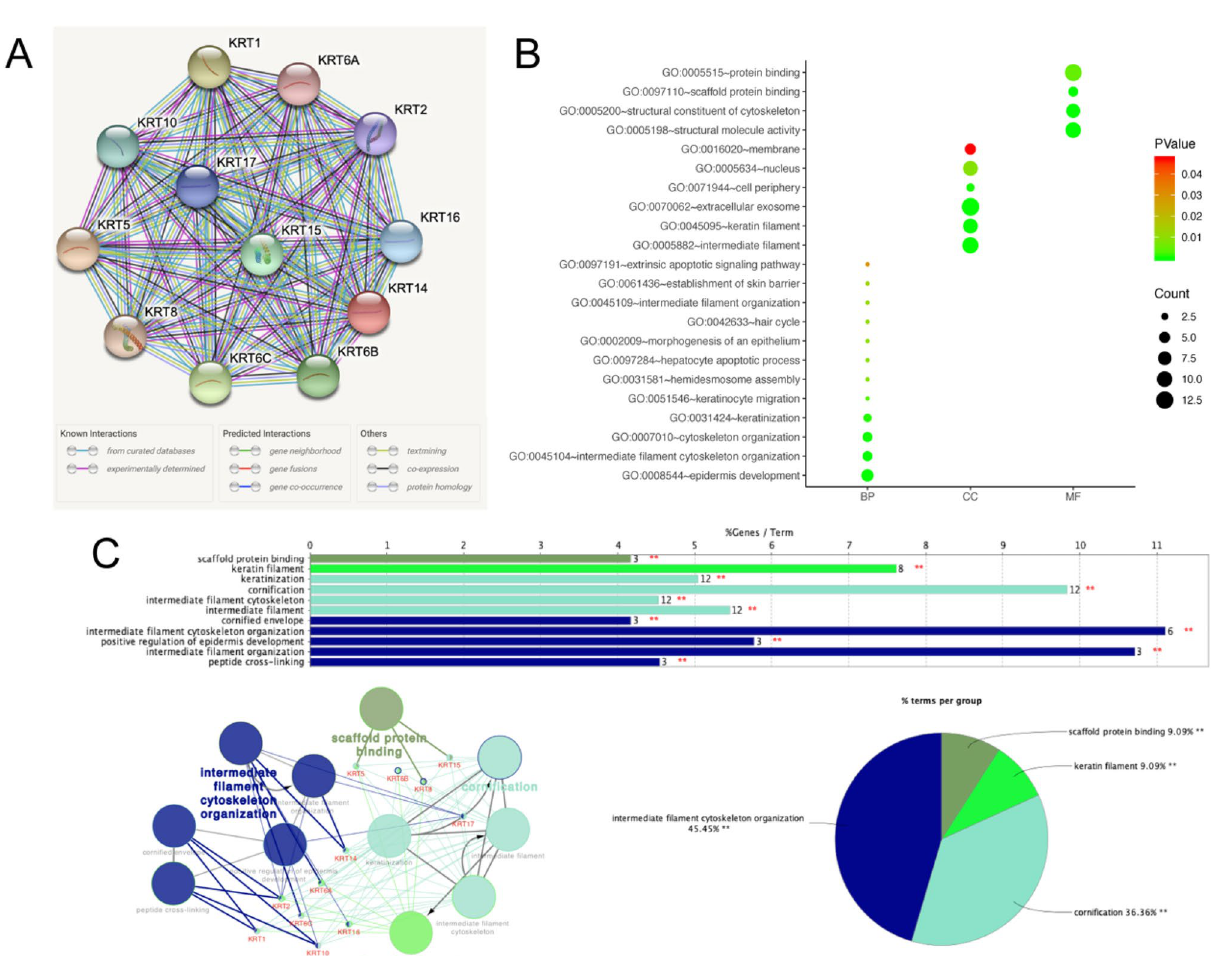
Figure 7. Functions enrichment and signaling pathways analysis of the mutations in KRTs in SKCM patients. ( A ) A PPI network analysis of differentially expressed KRTs with STRING was conducted to explore the potential interactions among them ( B ) Functional and pathway enrichment analyses of KRTs were performed using DAVID and visualized in bubble chart. ( C ) The functional annotation analysis of KRTs was constructed using ClueGO, a plug-in of